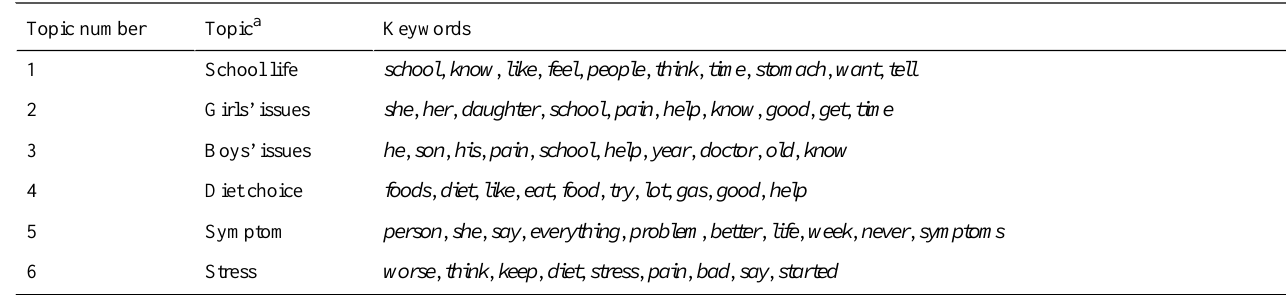
Table 1. The top 6 topics in the parents’discussion of their children’s irritable bowel syndrome issues.